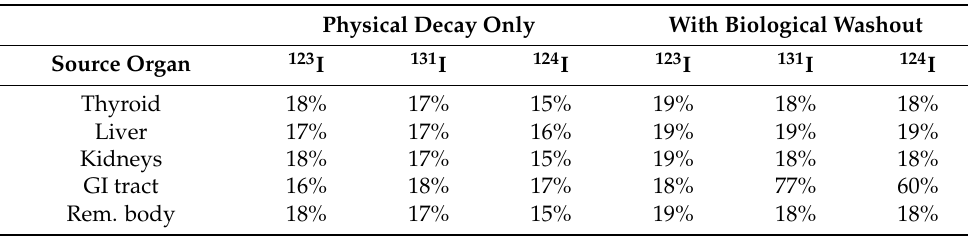
Table 5. Relative uncertainty of cumulated activities; the representative uncertainty for measuring activity, δ (cid:101) A / (cid:101) A , was assumed to be 20%. Physical Decay Only With Biological Washout Source Organ 123 I 131